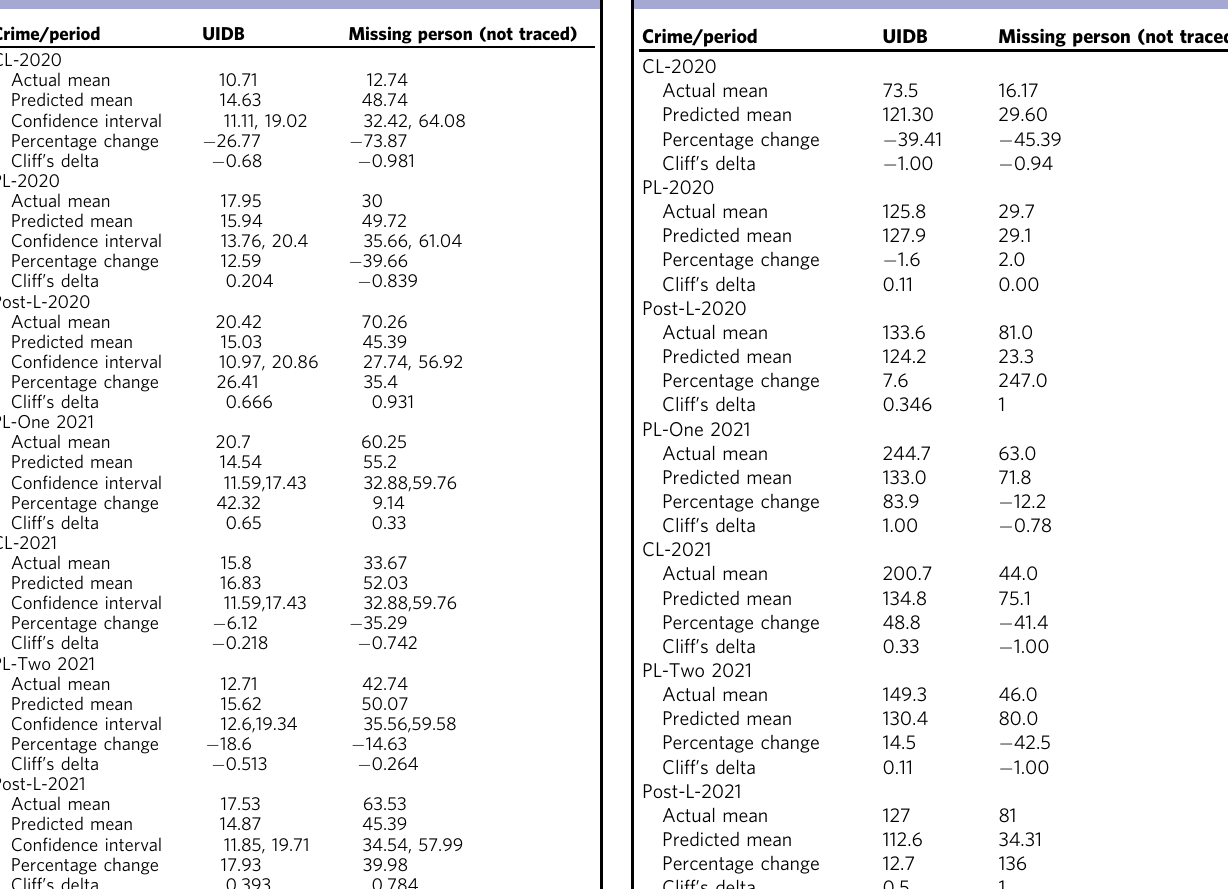
Table 5 Actual and predicted weekly counts of violent crimes during various phases of lockdowns in waves one and two in Tamil Nadu in 2020 – 21.